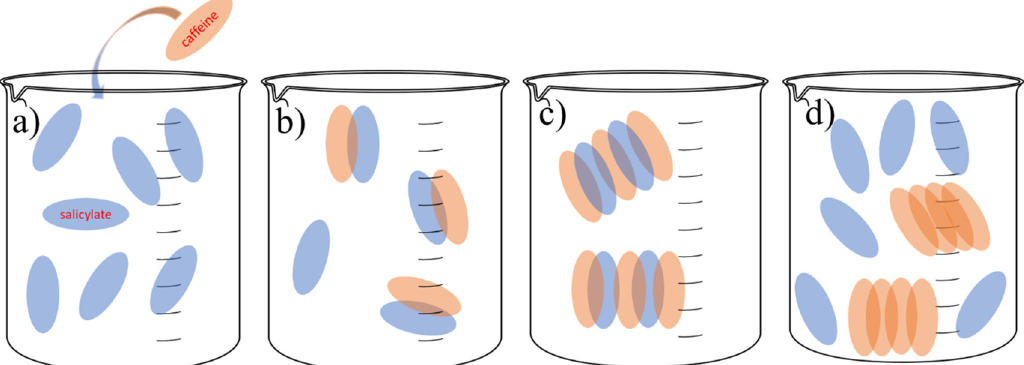
Figure 11. Visual representation of the potential role of salicylates in increasing the solubility of caffeine: ( a ) adding caffeine in SS solution, ( b ) forming π – π interactions between caffeine and salicylate anions, ( c ) caffeine and salicylate complexes that provide better solubility of caffeine monomers, and ( d ) forming caffeine–caffeine complexes through π – π interactions with salicylate anion